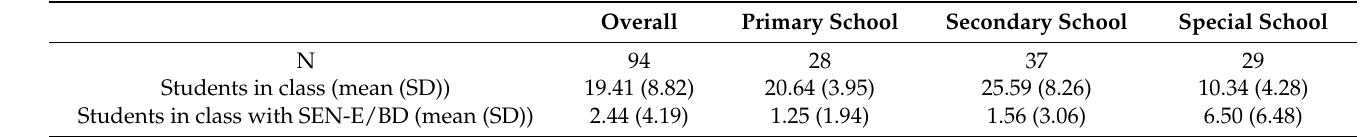
Table 1. Teachers participating in the survey.